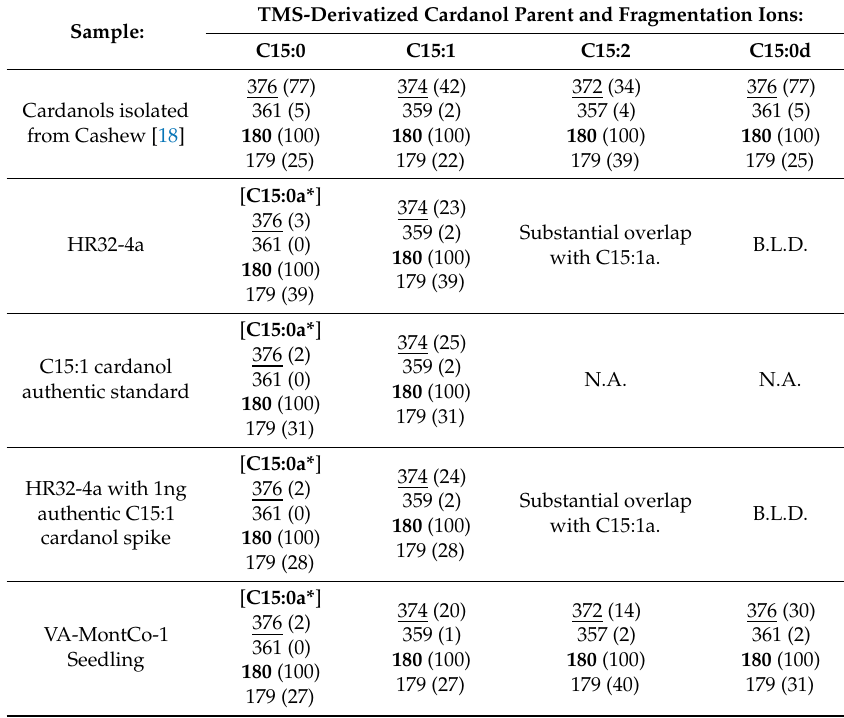
Table 1. Trimethyl-silane (TMS)-derivatized C15-cardanol congener parental and fragmentation m / z ratios. Bracketed text indicates actual congener. Underlined indicates parent ion m / z . Bold indicates common cardanol fragmentation ion m / z 180. Parentheses bound the percent abundance relative to the most abundant fragmentation m / z 180 ion.